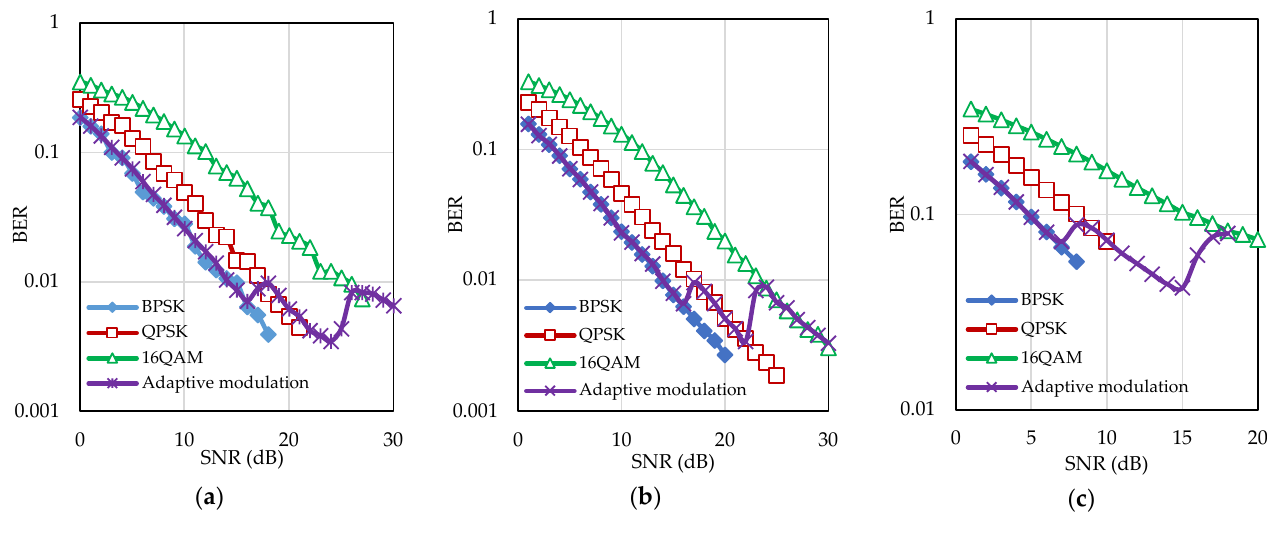
Figure 8. BER performance of the proposed adaptive modulation scheme for Doppler frequency ( a ) 0.0139 Hz, ( b ) 0.1386 Hz, and ( c ) 1.3856 Hz. Table 1. Switching thresholds used in simulation for frame-based adaptive modulation